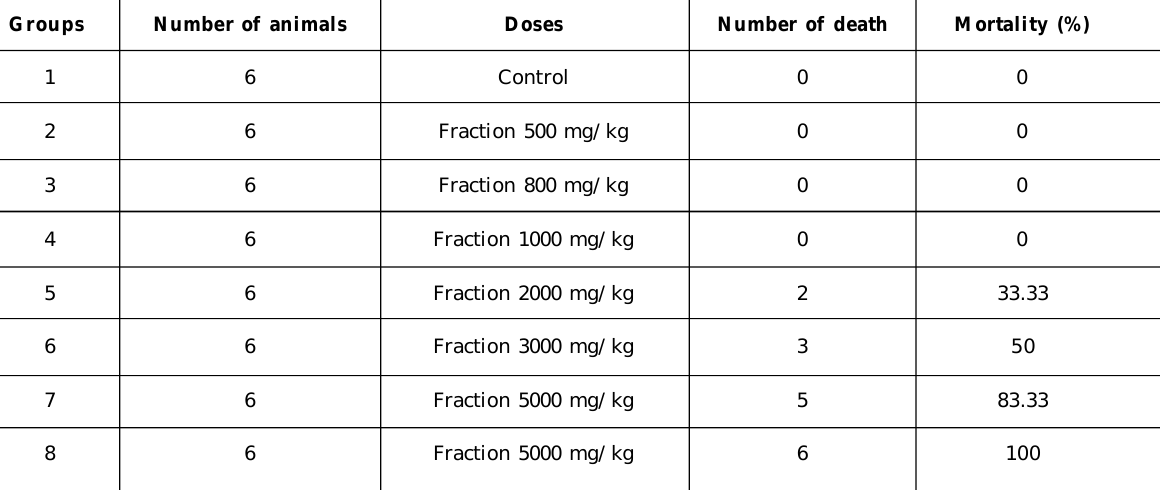
Table 3: Percentage of mortality in rats treated by fractions at different doses Groups